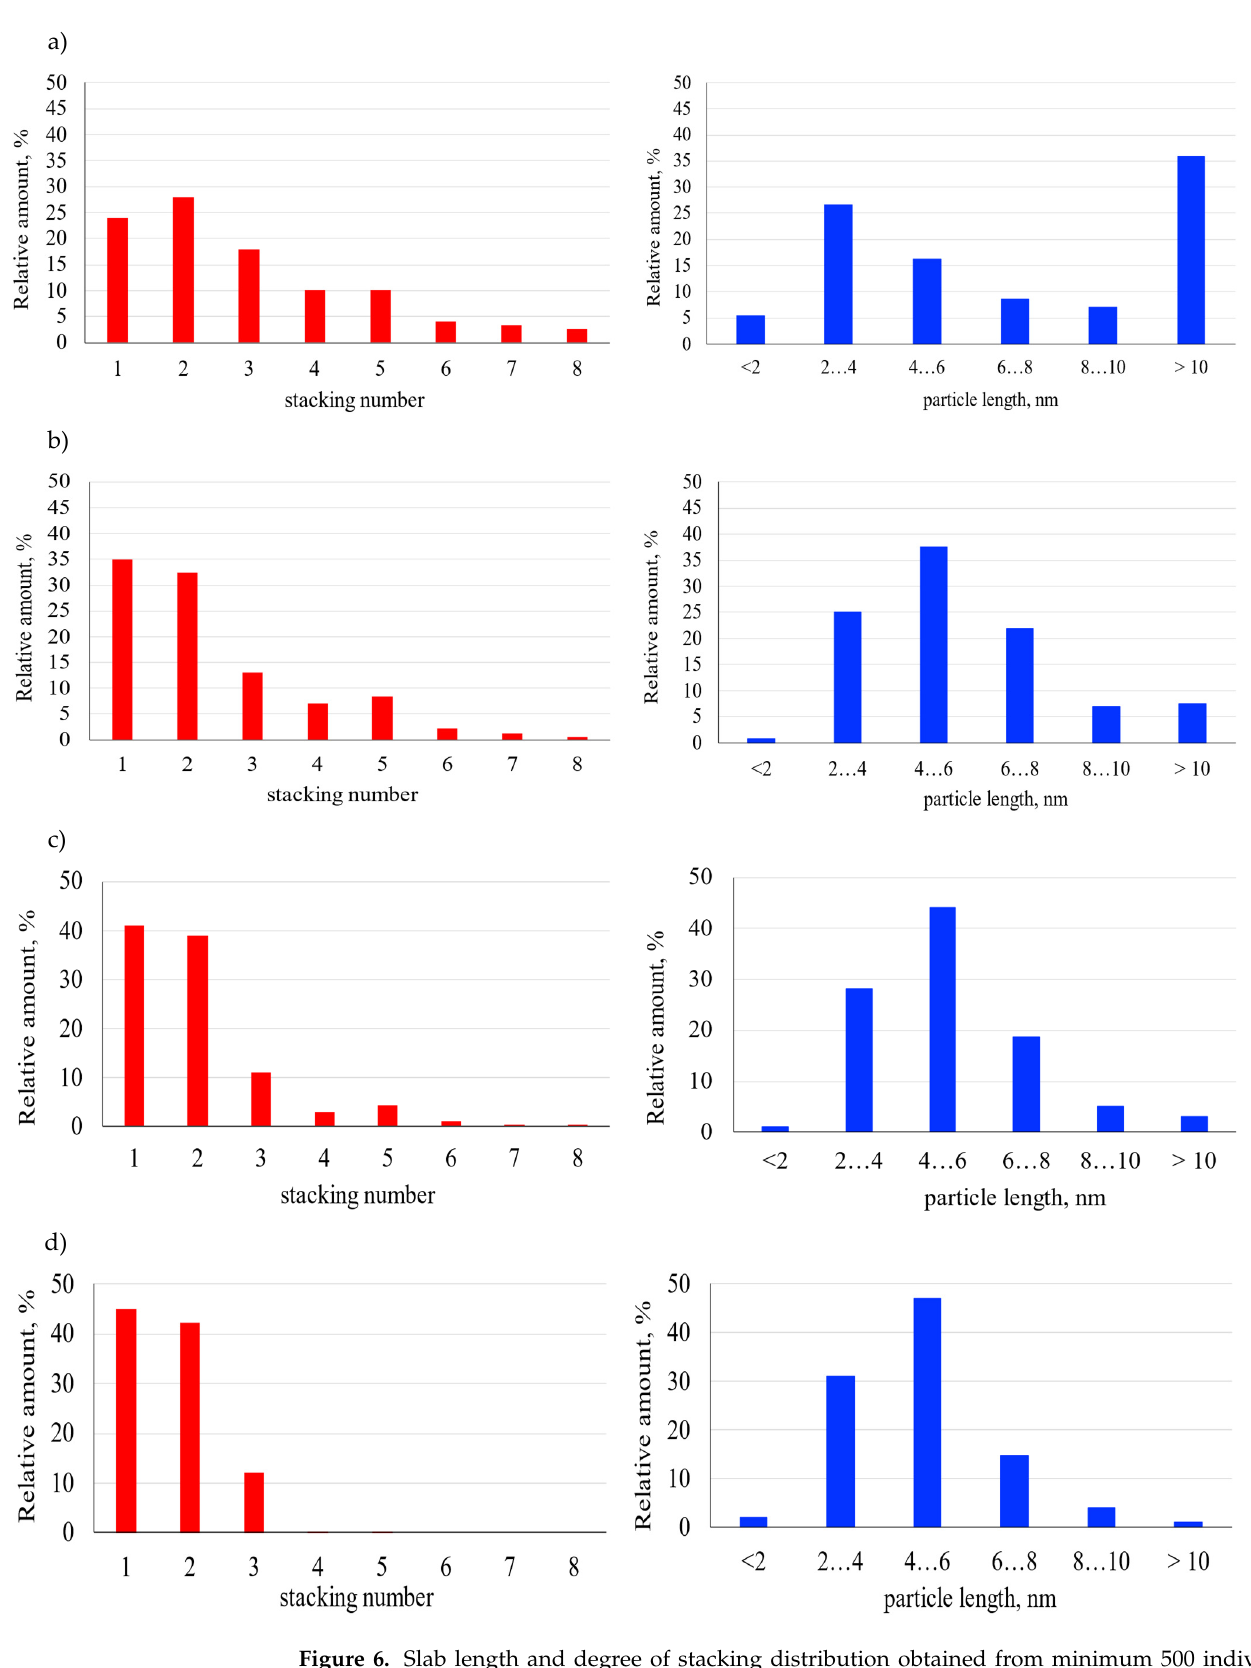
Figure 6. Slab length and degree of stacking distribution obtained from minimum 500 individual slabs per sample as recorded from TEM images. ( a ) KCoMoS 2 /TCA; ( b ) KCoMoS 2 /AHM; ( c ) KCoMoS 2 /YPK-1; ( d ) KCoMoS 2 /DAS.